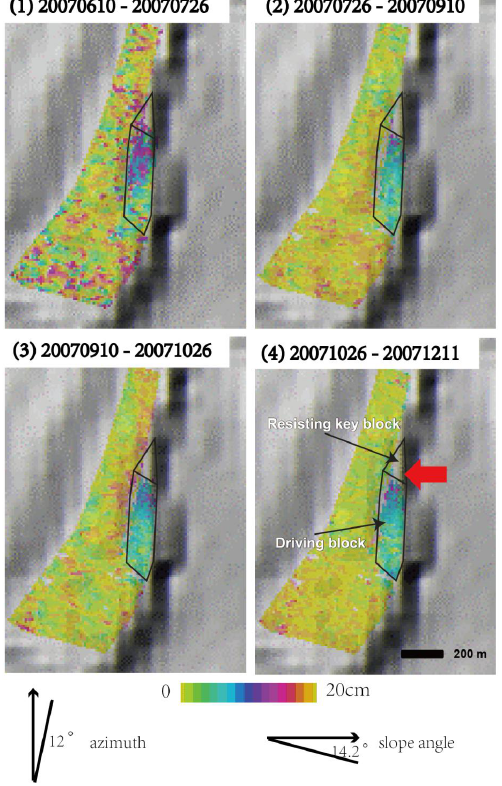
Fig. 5. Deformation maps within 46 days over the Jiweishan region before the 5 June 2009 slide, the red arrow indicates the same location as shown in Fig. 4. The slide geometry is shown at the bottom of the figure.